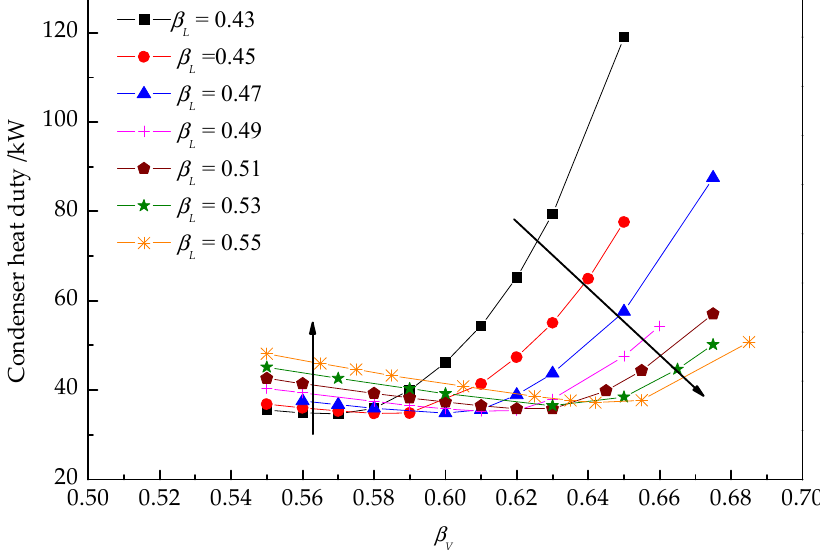
Figure 13. The effect of vapor split ratio on condenser heat duty for the case study.